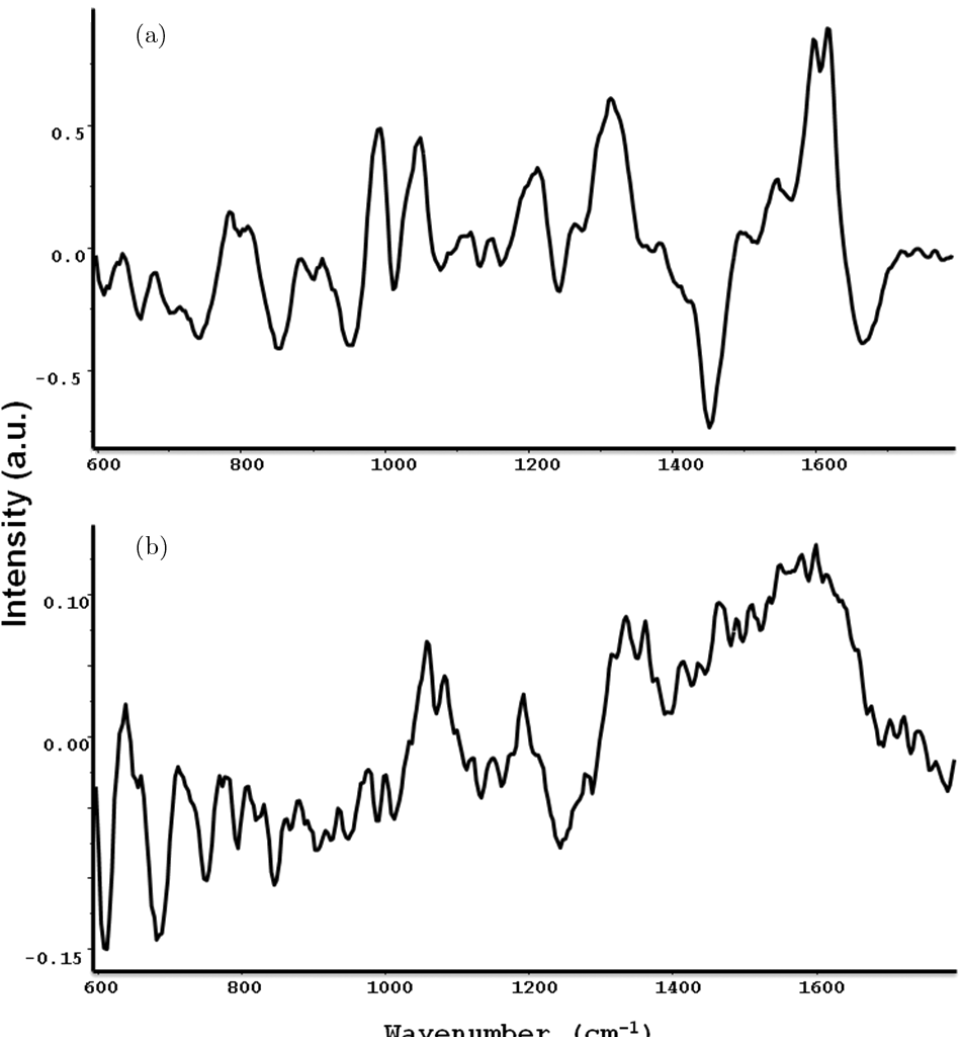
Fig. 3. Di®erence spectra for DCDR approach (a) Highest concentration (2 mg) — blank plasma, (b) Lowest concentration (0.1mg) — blank